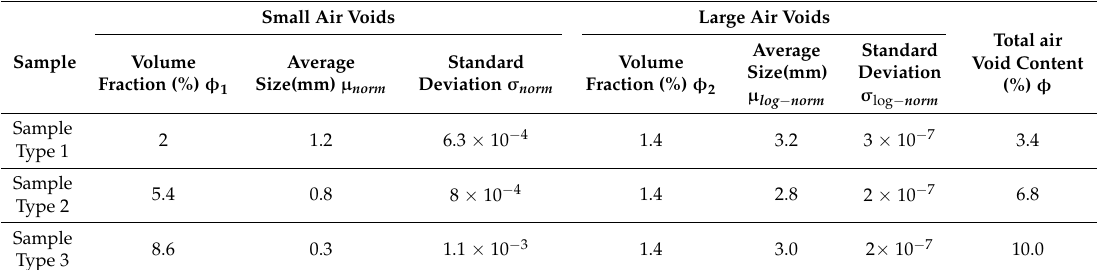
Table 3. Inverse analysis of parameters for combined